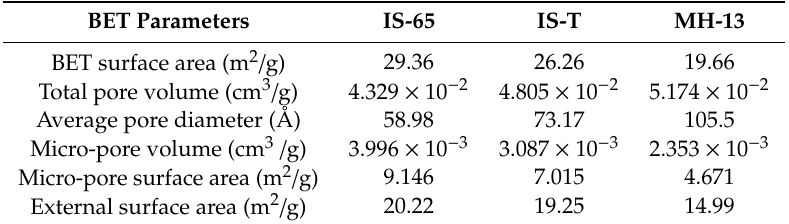
Table 4. Soil porosity characteristics [33].